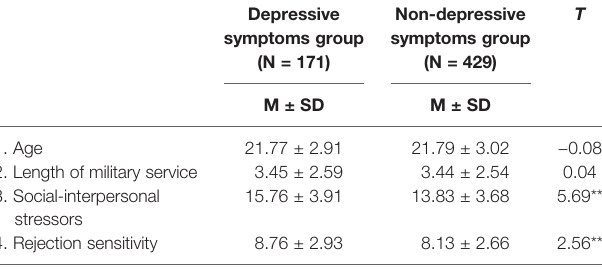
TABLE 1 | Test of the variable differences between the depressive symptoms and non-depressive symptoms groups.